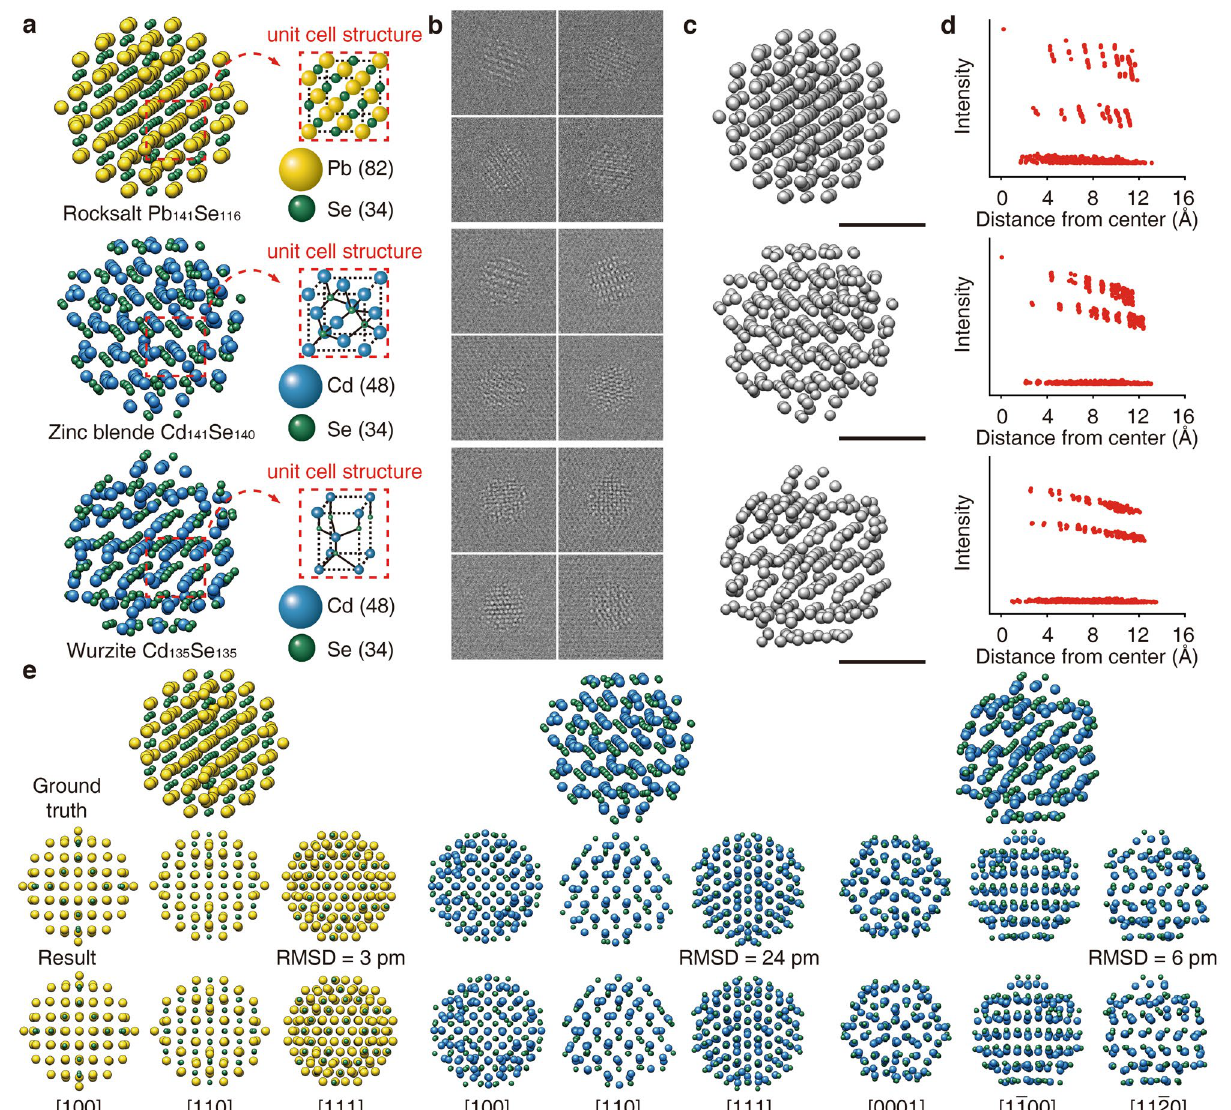
Figure 3. 3D reconstruction process for ordered multi-element nanoparticles. (top row: rocksalt PbSe, middle row: zinc blende CdSe, bottom row: wurtzite CdSe) ( a ) Ground truth atomic structures. Yellow, green, and blue spheres correspond to Pb, Se, and Cd atoms, respectively. Ground truth structures are geometrically optimized by DFT calculations. ( b ) Representative simulated TEM images. ( c ) 3D Coulomb density maps obtained by single-step reconstruction. ( d ) Plots of distance from center of mass as a function of local maximal intensity. ( e ) Atomic structures obtained from 3D Coulomb density maps with atom type classification. The reconstructed atomic structures are compared with the ground truth structures along different zone axes. Root mean square displacement (RMSD) between input and reconstructed structures are depicted. Scale bars, 1